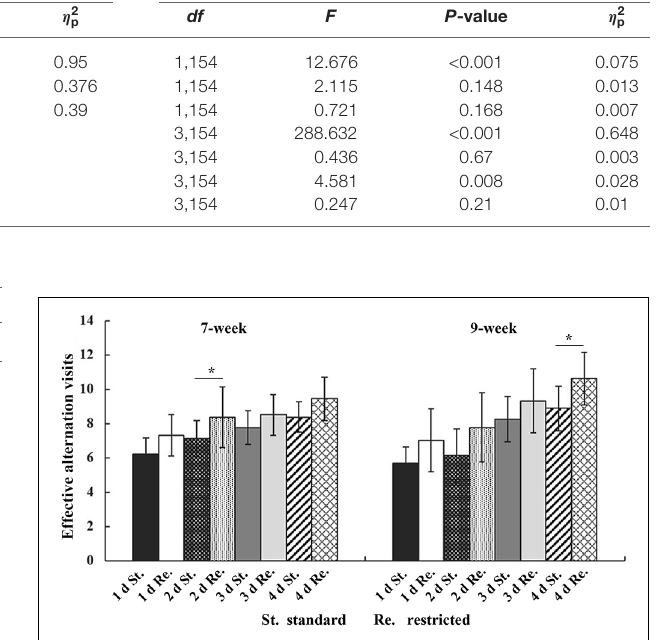
FIGURE 3 | The effective alternation visits of mice in T -maze test. The error bars mean standard deviations. Statistically significant differences compared with standard group. * P < 0.05, n = 40 per group. St., standard cage groups; Re., restricted cage